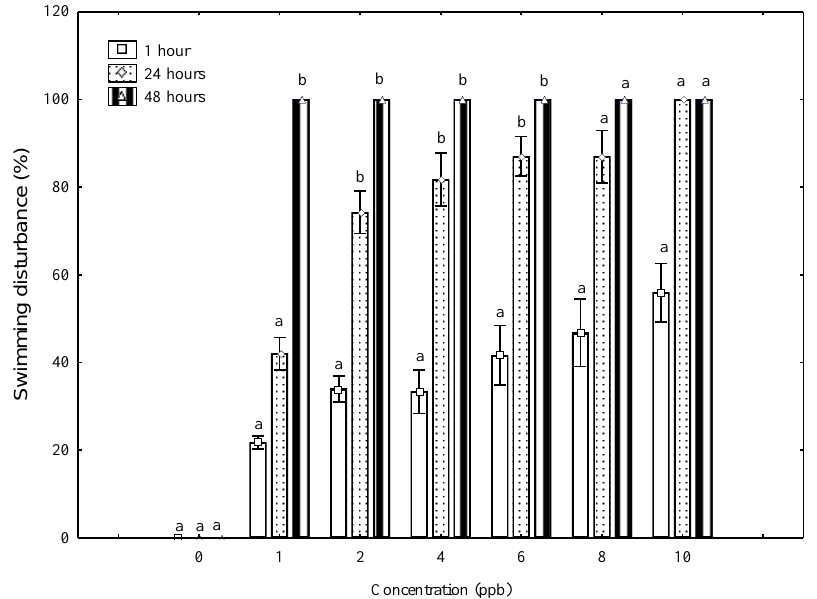
Figure 2. Distribution of swimming ability perturbation according to tested cypermethrin concentrations and time. Error bars indicate average ± standard deviation. For each concentration, different heading letter indicate significant difference (ANOVA 1, p < 0.05).